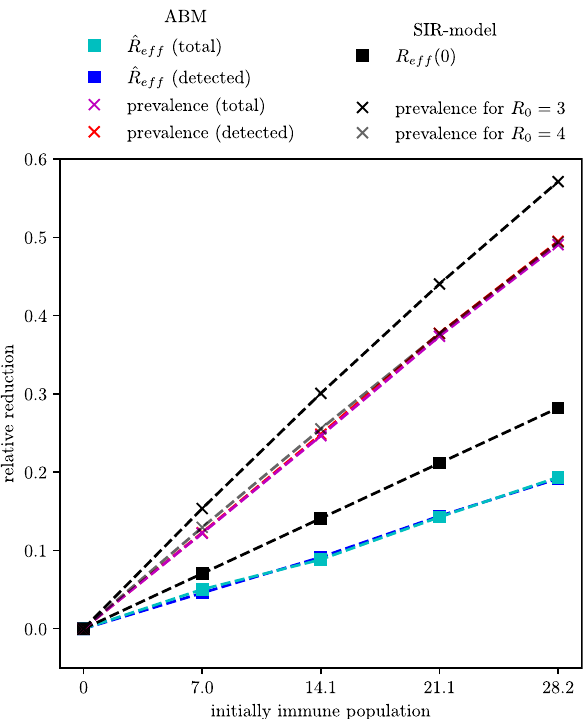
Figure 7. Relative reduction of the effective reproduction number and the peak of the prevalence compared to a fully susceptible population for the results of the classic SIR-model and of the agent-based simulation